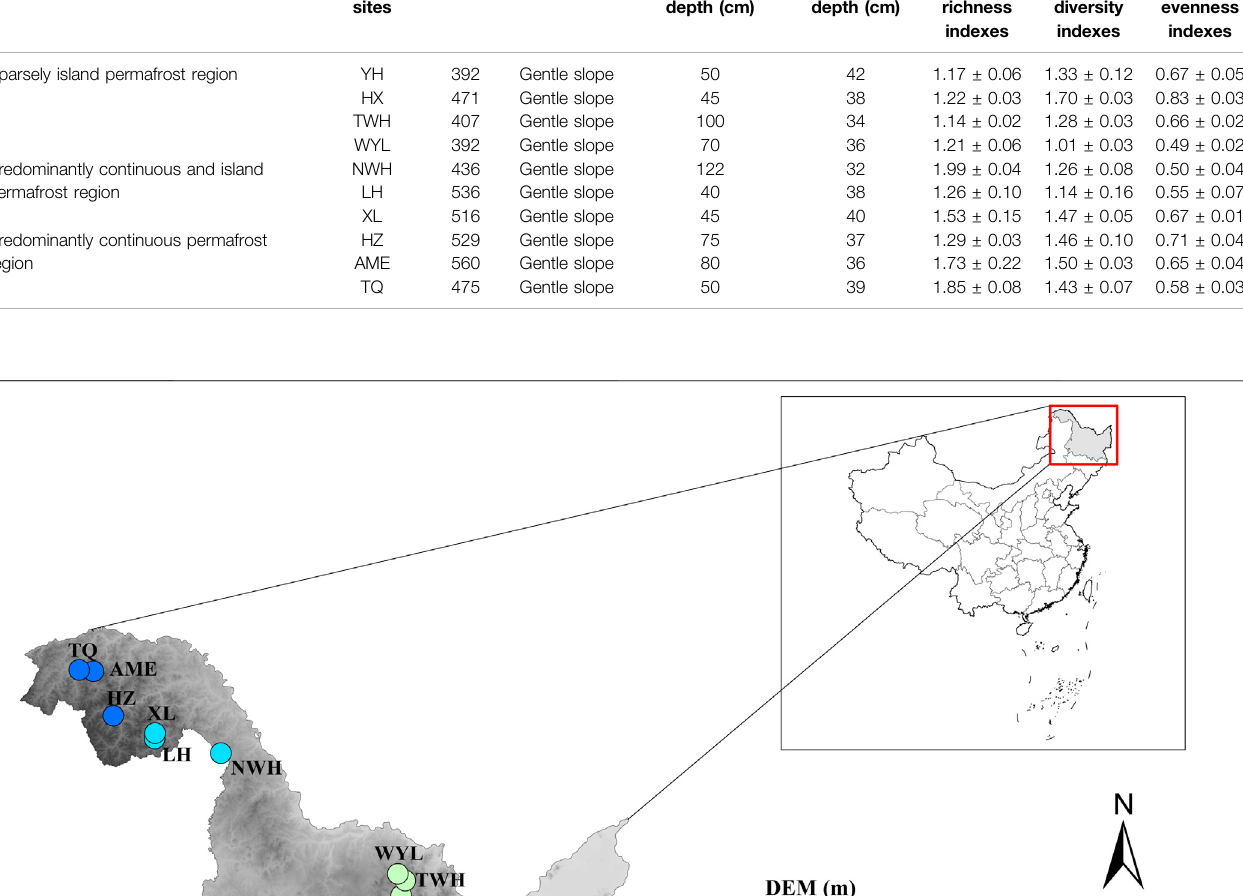
Altitude Topography Thawing sites depth (cm)